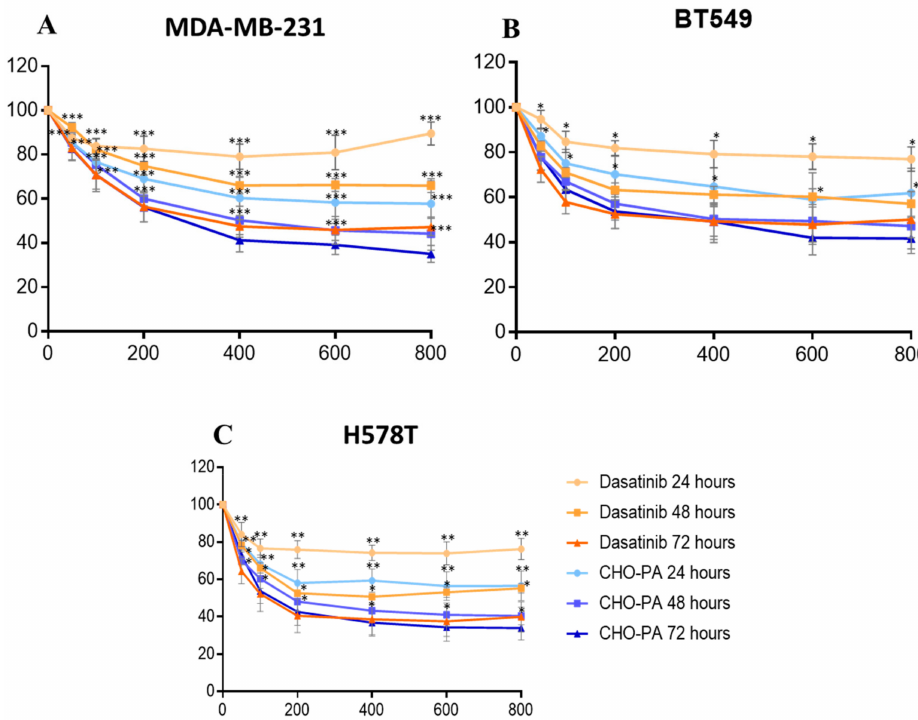
Figure 6. Time-course e ff ect of DAS and DAS-loaded CHO / PA NPs (CHO / PA) on cell viability in ( A ). MDA-MB-231, ( B ). BT549 and ( C ). HS578T. Data are expressed as mean ± s.e.m. from at least three independent experiments. p < 0.05* p < 0.01** p <